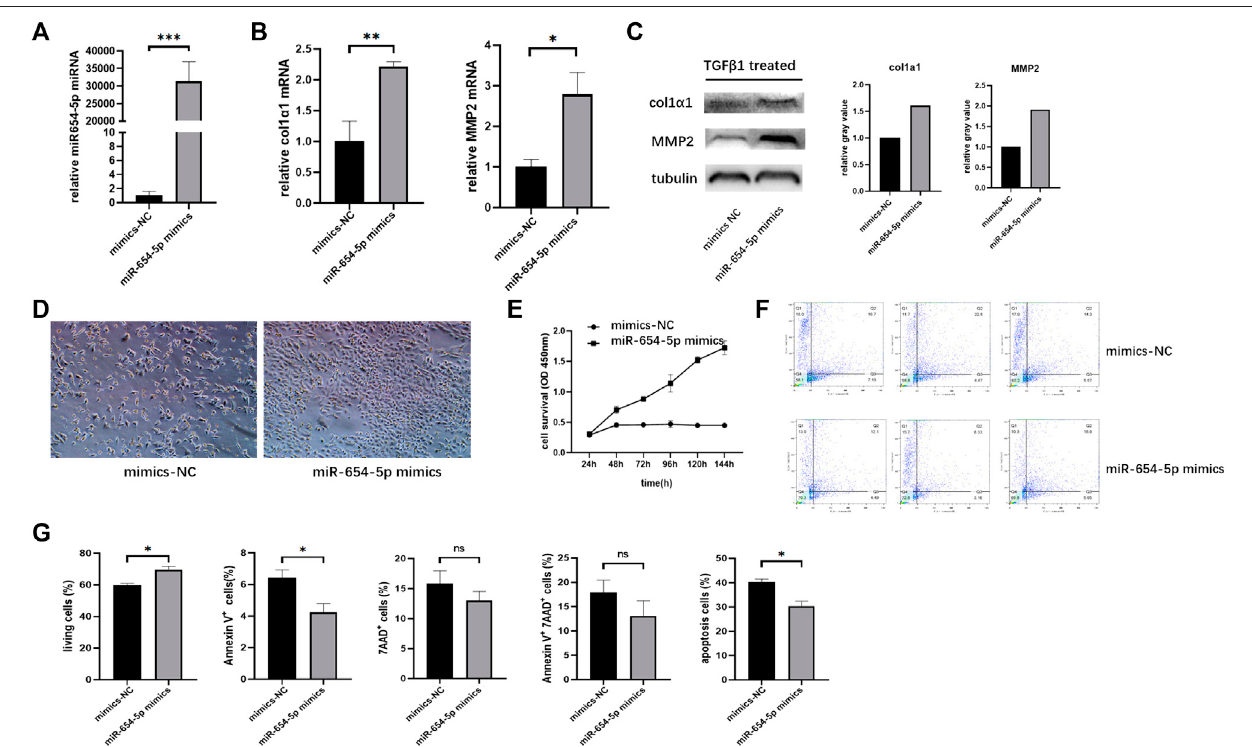
FIGURE 3 | Upregulation of miR-654-5p expression promotes activation and proliferation of LX-2 cells while inhibiting their apoptosis. (A) MiRNA-654-5p expression levels in LX-2 cells transfected with miR-654-5p mimics versus LX-2 cells transfected with mimics-NC (B) col1 α 1 and MMP2 mRNA expression levels in miR-654-5p overexpressing LX-2 cells versus the control group. (C) Expression of col1 α 1 and MMP2 protein in miR-654-5p overexpressing LX-2 cells versus in control group (D) Quantity and morphology of LX-2 cells transfected with mimics-NC and LX-2 cells transfected with the miR-654-5p mimic (cells were photographed under light microscopic fi eld, 40× magni fi cation). (E) Effects of miR-654-5p mimics on the growth of LX-2 cells. Cells were transfected with the hsa-miR-654-5p mimics. CCK-8 assay evaluated cell survival (F) Effects of the hsa-miR-654-5p mimics on apoptosis of LX-2 cells (G) Flow cytometric analysis ofapoptotic cells ratio. Cells were transfected with thehsa-miR-654-5p mimics and cultured in an FBS-free medium for 5 days. Error bars represent mean ± SEM of at least three independent experiments. * p < 0.05, ** p < 0.01, and *** p < 0.001; NS, p > 0.05.